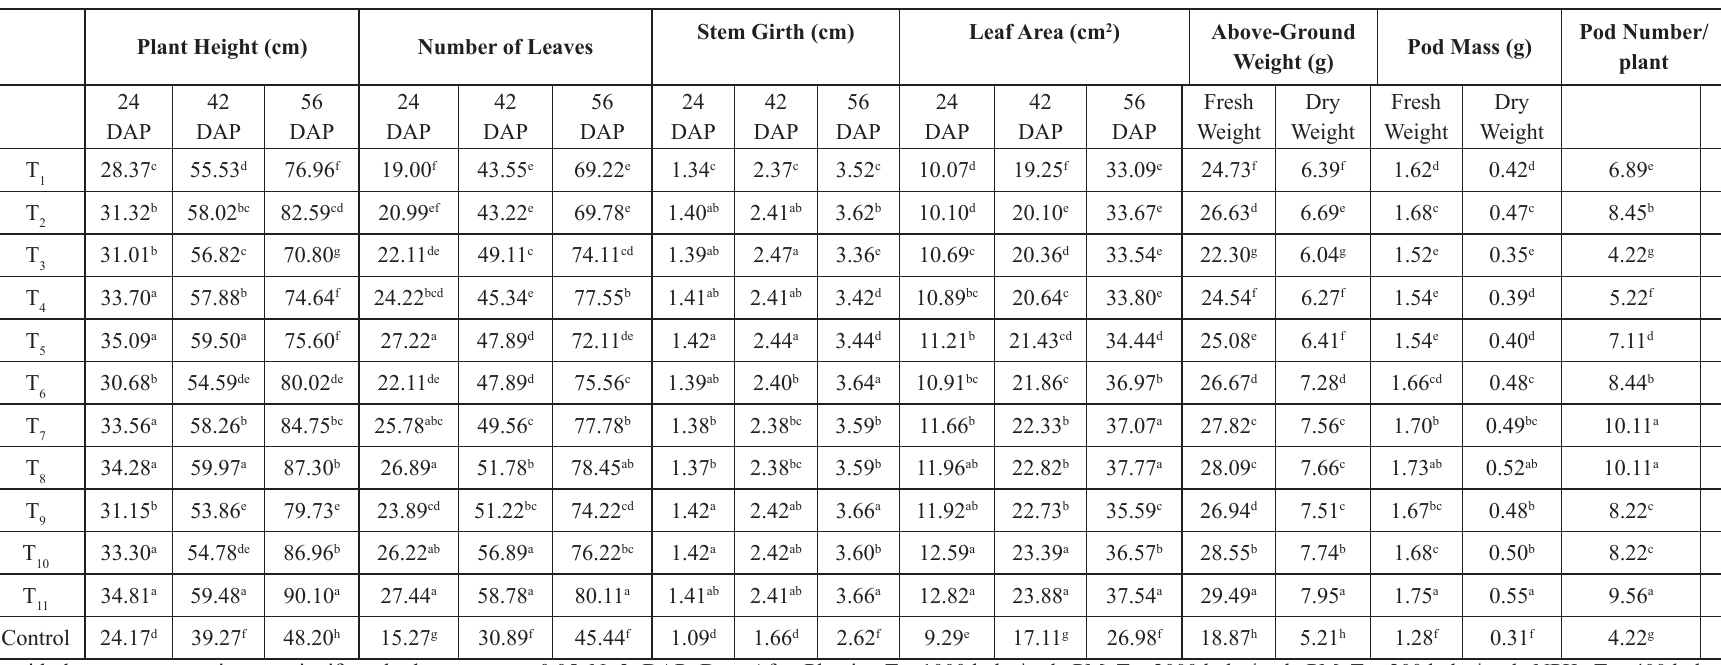
Stem Girth (cm) Leaf Area (cm 2 ) Above-Ground